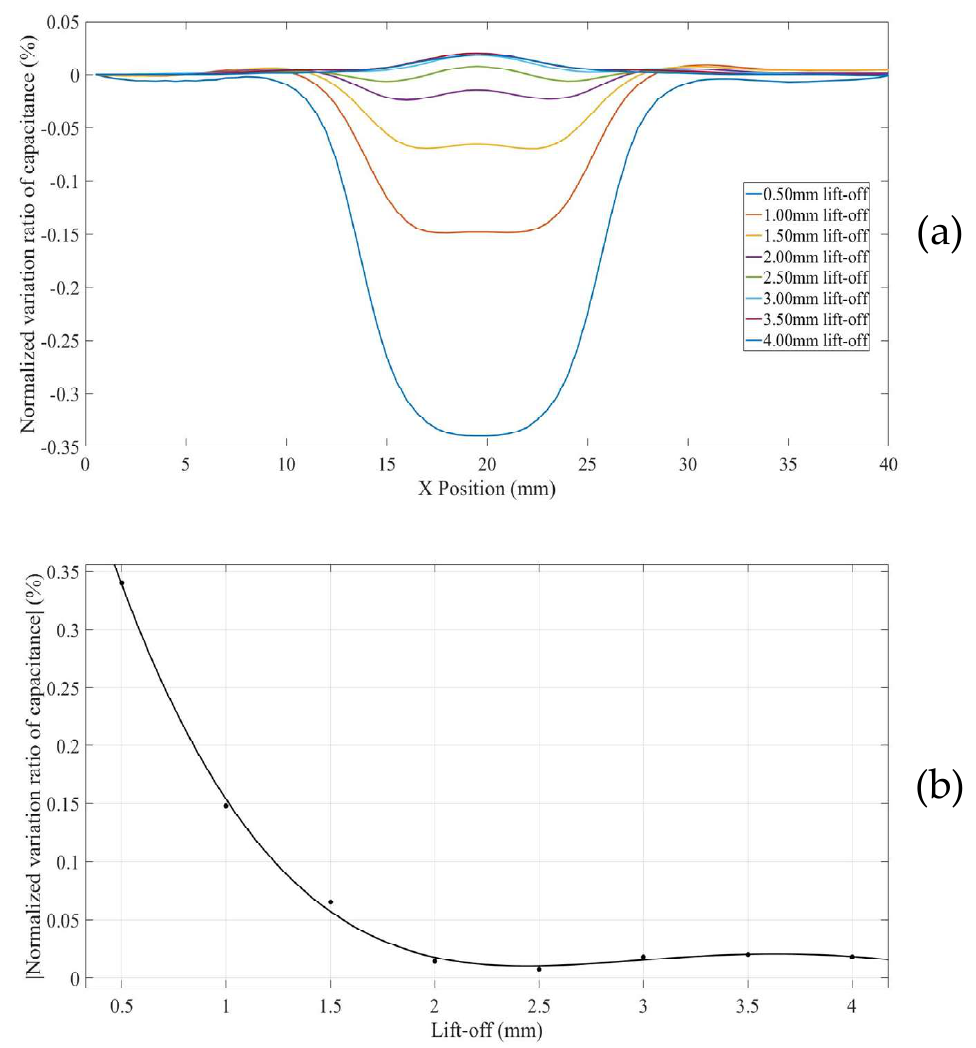
Figure 17. ( a ) NVR curves for the through hole on specimen I (placed on a thick insulation plate) with lift-offs increased from 0.5 mm to 4 mm ( b ) absolute values of the NVRs at the centre point against lift-offs.